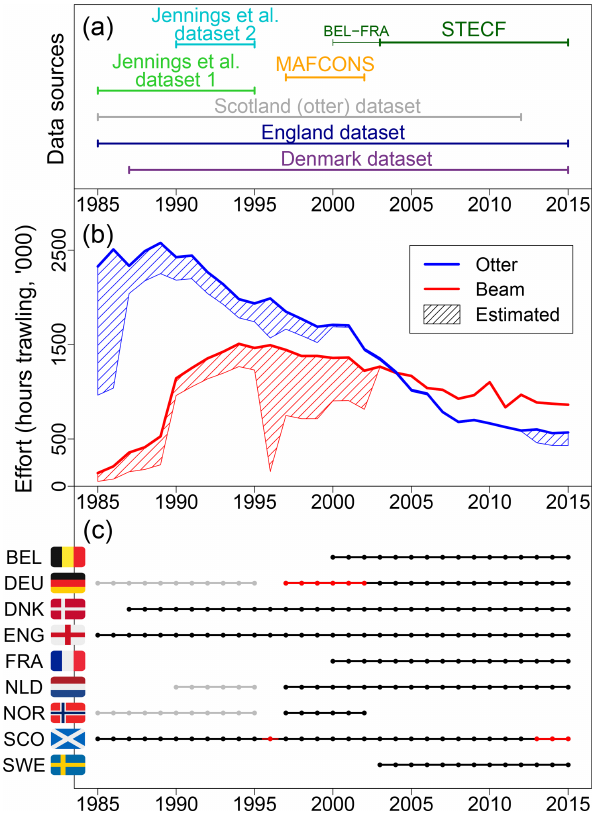
Figure 1. (a) The timelines for seven sources of compiled (nomi- nal) fishing effort data, included in the present study; see methods section for full details of each dataset. (b) Reconstructed total fish- ing hours in the North Sea by beam (red) and otter trawlers (blue), from 1985 to 2015. White-shaded areas show the proportions of the reconstructed total based on compiled (nominal) fishing effort data, and dashed areas show the proportions based on estimated (mod- elled) data. (c) The timelines, by country, for which nominal effort data were available and compiled for this study. The periods shown in grey indicate years for which country data were available but only as part of a compiled set, and the individual country contribution to the total was unknown (this is data which therefore could not be used to estimate missing periods). The periods shown in red indi- cate years for which only part of the data were available, or there was an issue with the compiled